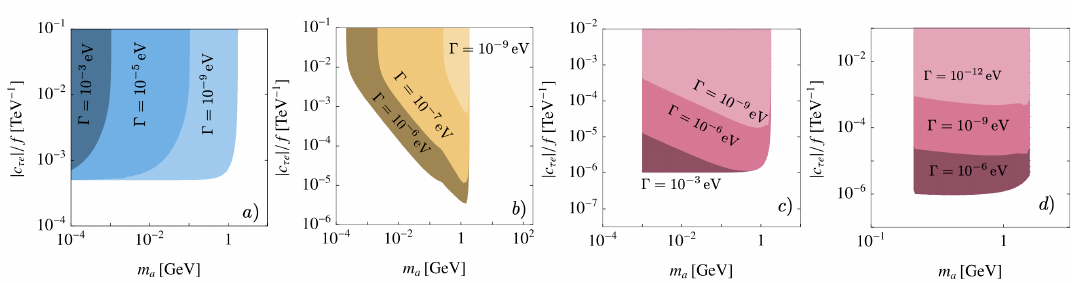
Figure 36 . Constraints on the flavor-violating ALP couplings c τe from tau decays, collected in table 2, for different values of the total ALP width. The color-coding indicates the final state: blue for invisible final states, yellow for ALP decays into photons, and red for a → e + e − and a → µ + µ −